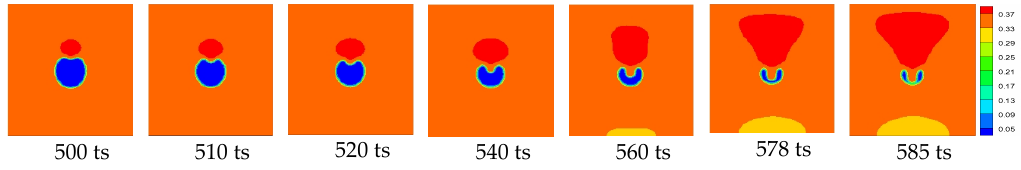
Figure 4. Density field of the LBM simulation: λ = 1.6, 𝑅 0 = 80 lu.